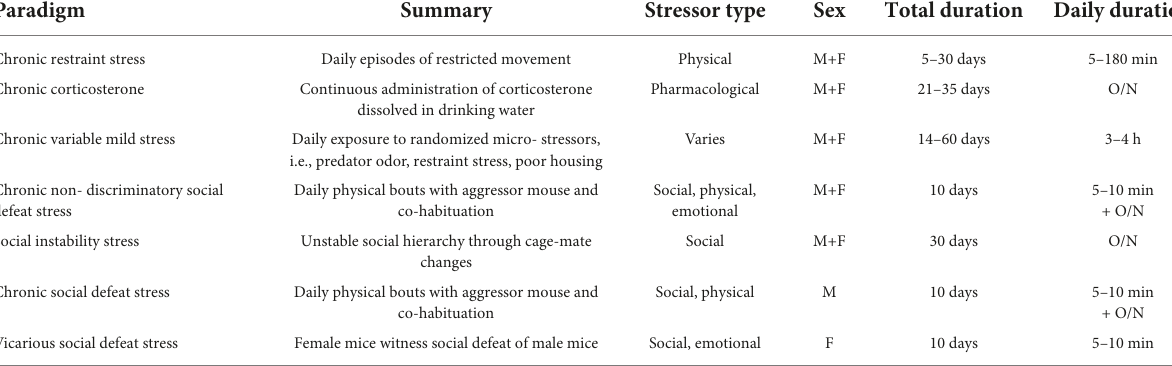
TABLE 1 Behavioral paradigms commonly used to induce stress-response in